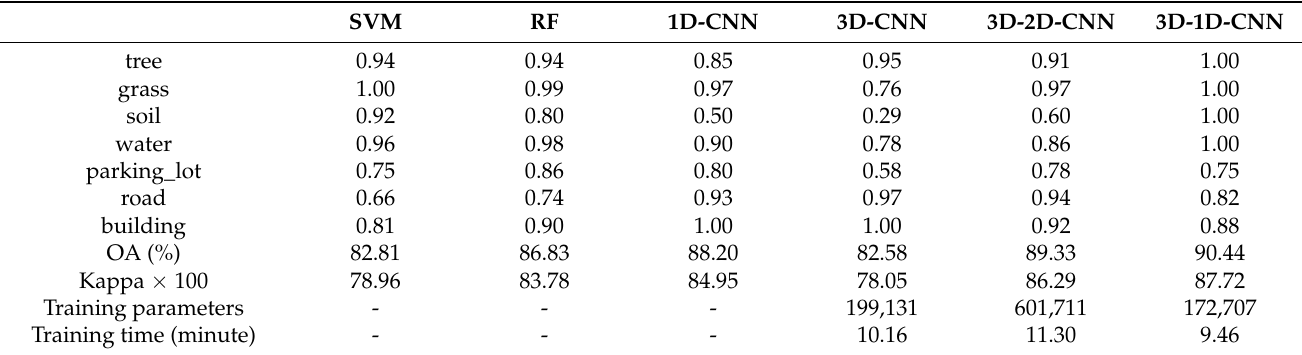
Table 7. Accuracy of each class with different classification methods for Surrey dataset.